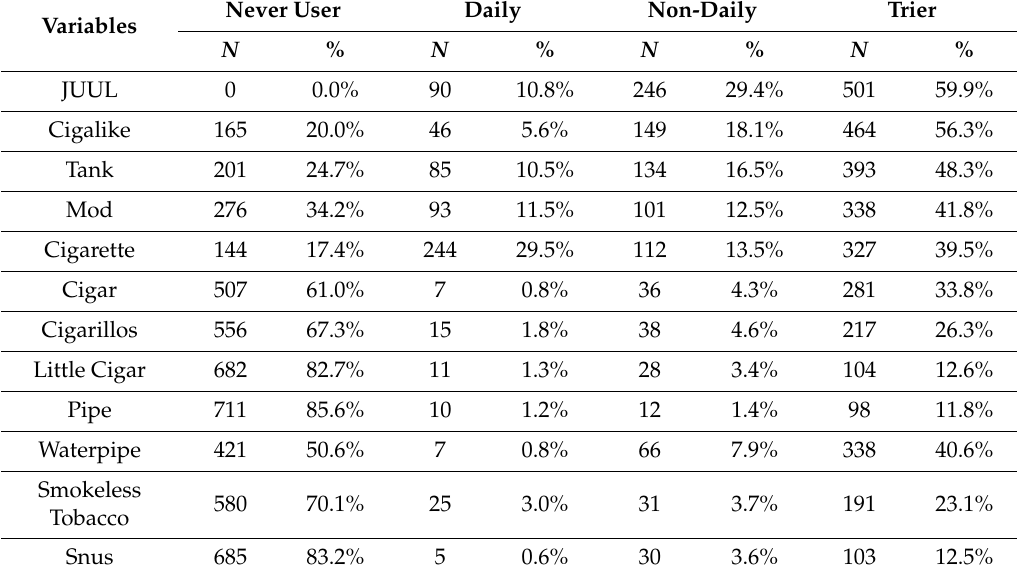
Table 1. Frequency of JUUL use and other tobacco products.